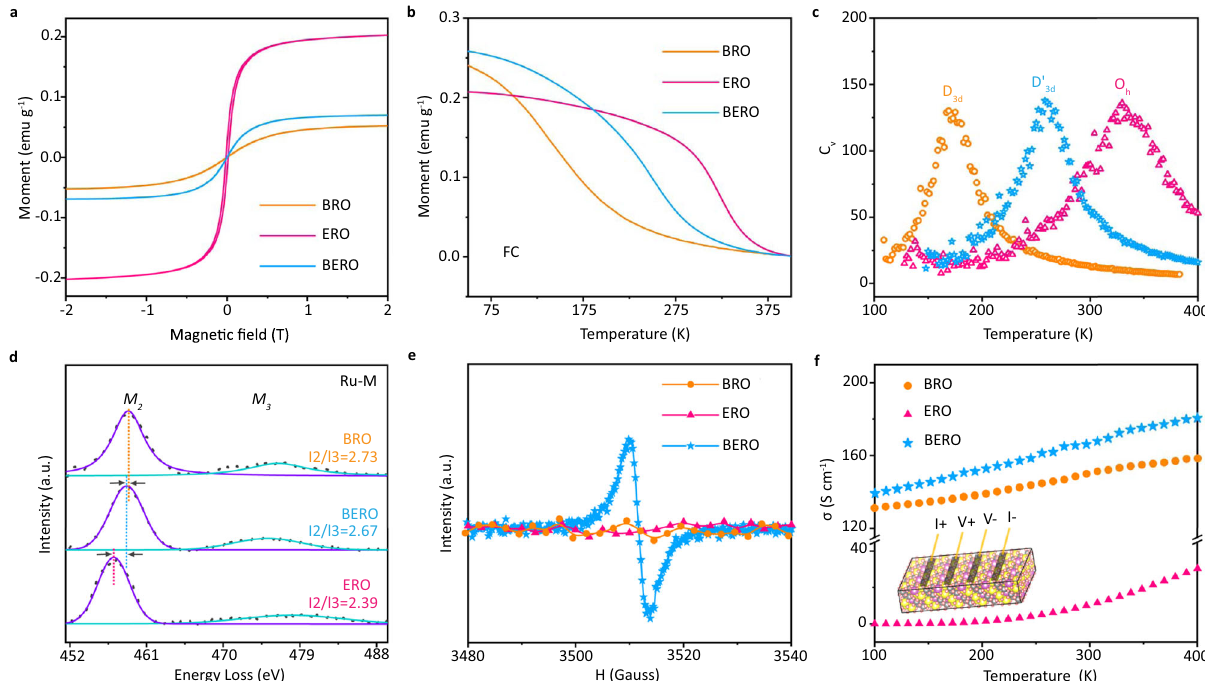
Fig. 3 Spin-related electronic structure characterization. a Room temperature magnetic hysteresis loops of BERO, BRO and ERO. b Temperature dependence of the magnetic susceptibility measured at 1000 Oe external magnetic- fi eld cooling (FC). c The speci fi c heat C v as a function of temperature. d EELS spectra, ( e ) ESR spectra and ( f ) The electrical conductivity of BERO, BRO and magnetic fi eld (M-H) for different pyrochlores are conducted in Fig. 3a by a superconducting quantum interference device (SQUID) at room temperature. They all display nonlinear hysteresis loop curves, demonstrating a room-temperature